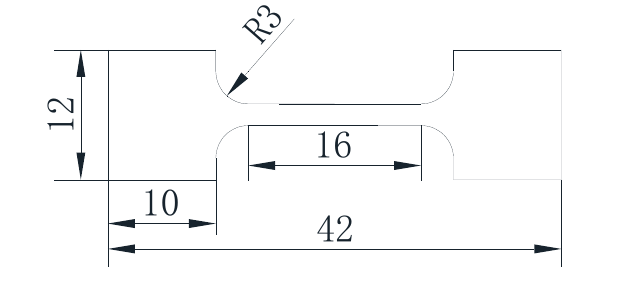
Figure 1. Tensile specimen size (mm).